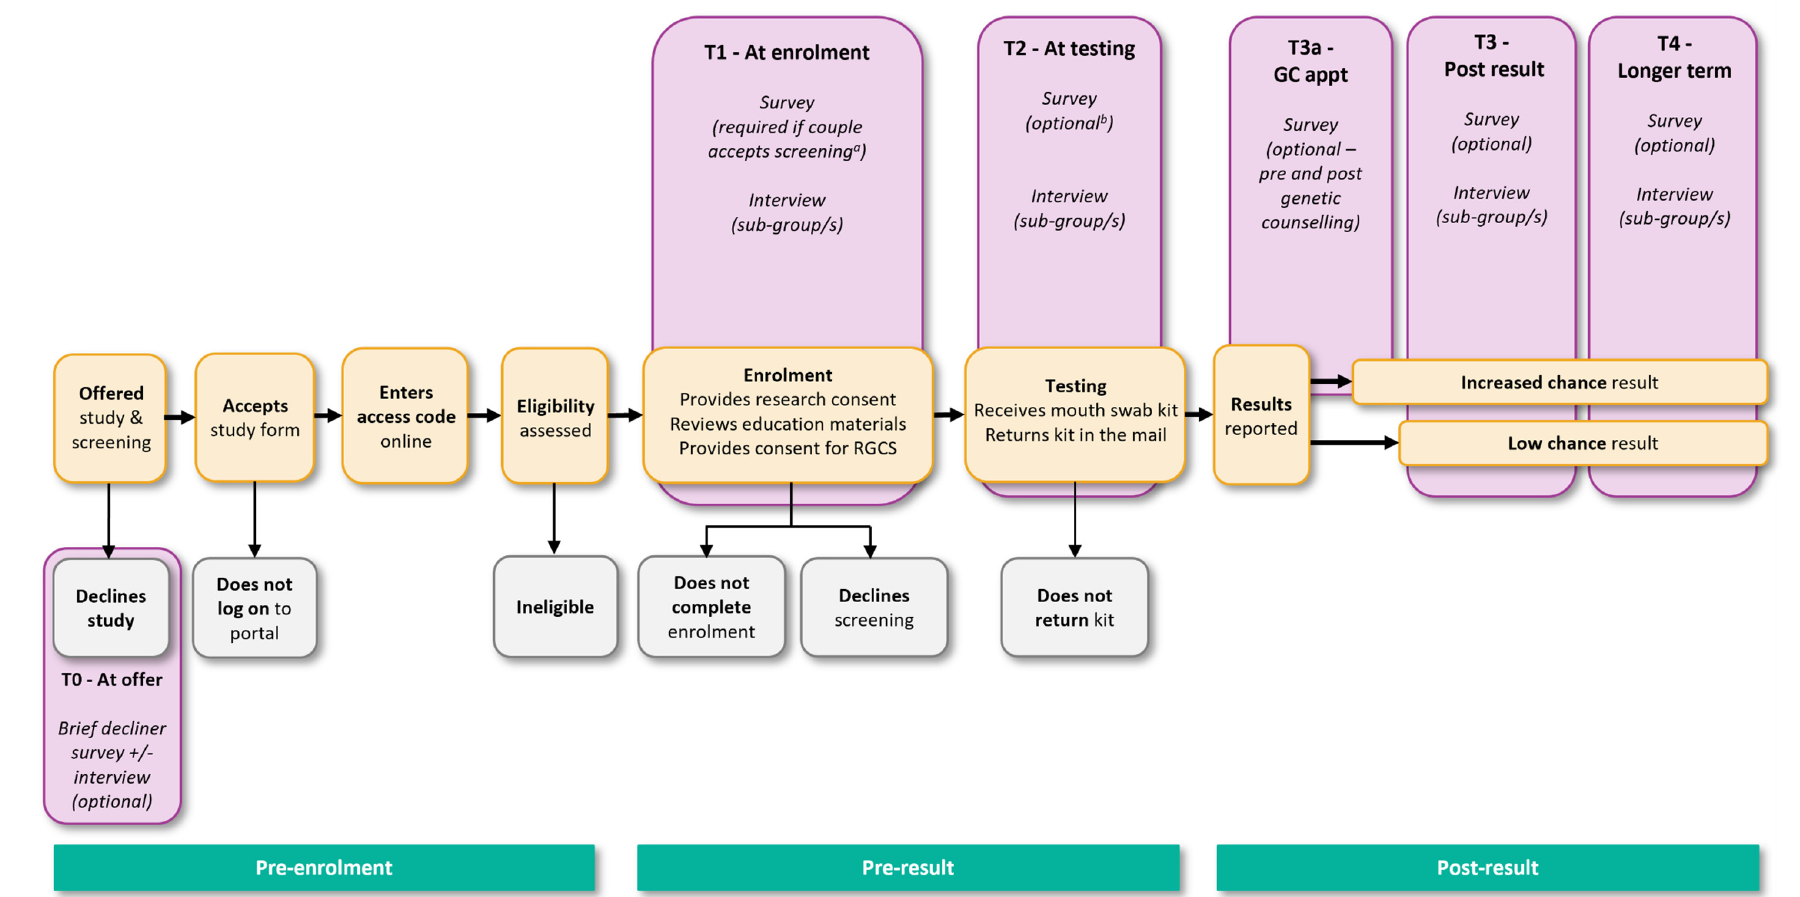
Figure 3. Data collection timepoints for people offered reproductive genetic carrier screening in the Mackenzie’s Mission study. a Participants who do not complete the enrollment or decline screening may also complete this survey. b Participants who do not return their mouth swab kit may also complete this survey.